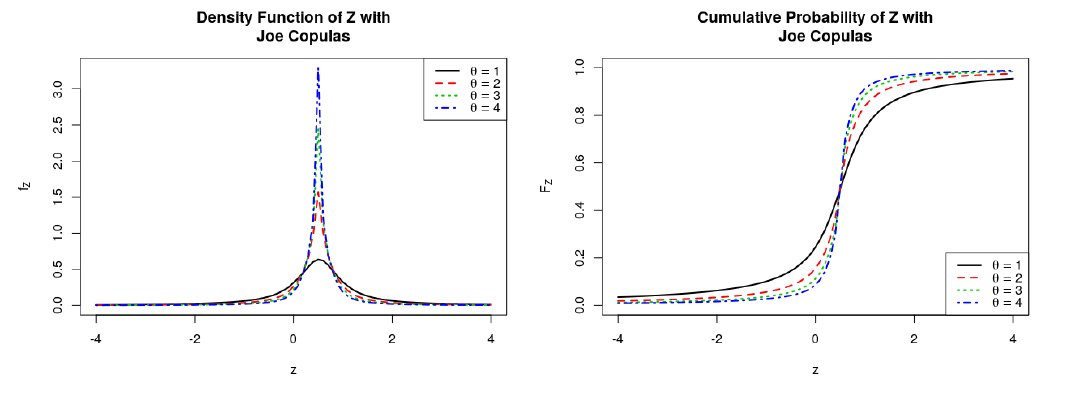
, where ( X 1 , X 2 ) follows Joe X 1 + X 2